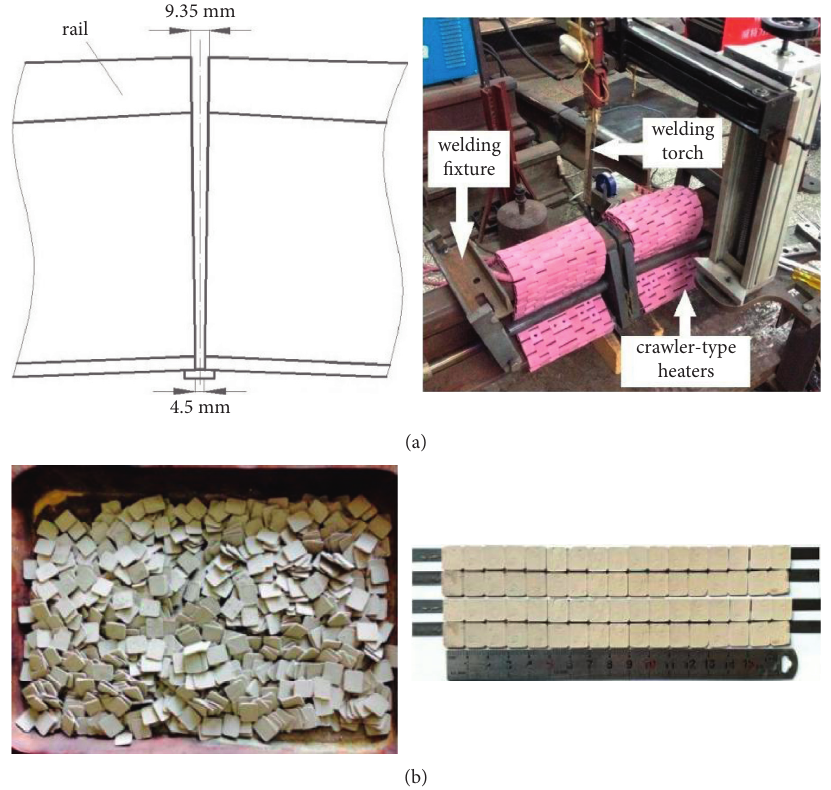
Figure 2: Real picture of rail ultranarrow gap welding device. The picture of (a) groove and (b) flux band.